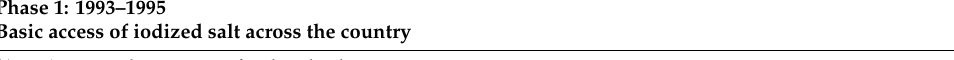
Table 1. Phases and targets of the National Plan for the Control and Prevention of Key Endemic Diseases [22]. IDD, iodine deficiency